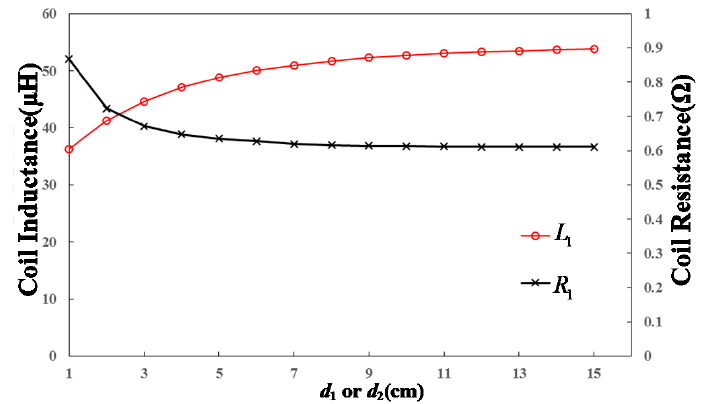
Figure 6. Inductance and resistance of the coil versus the distance when the iron metal object is placed along the line l 1 or l 2 .